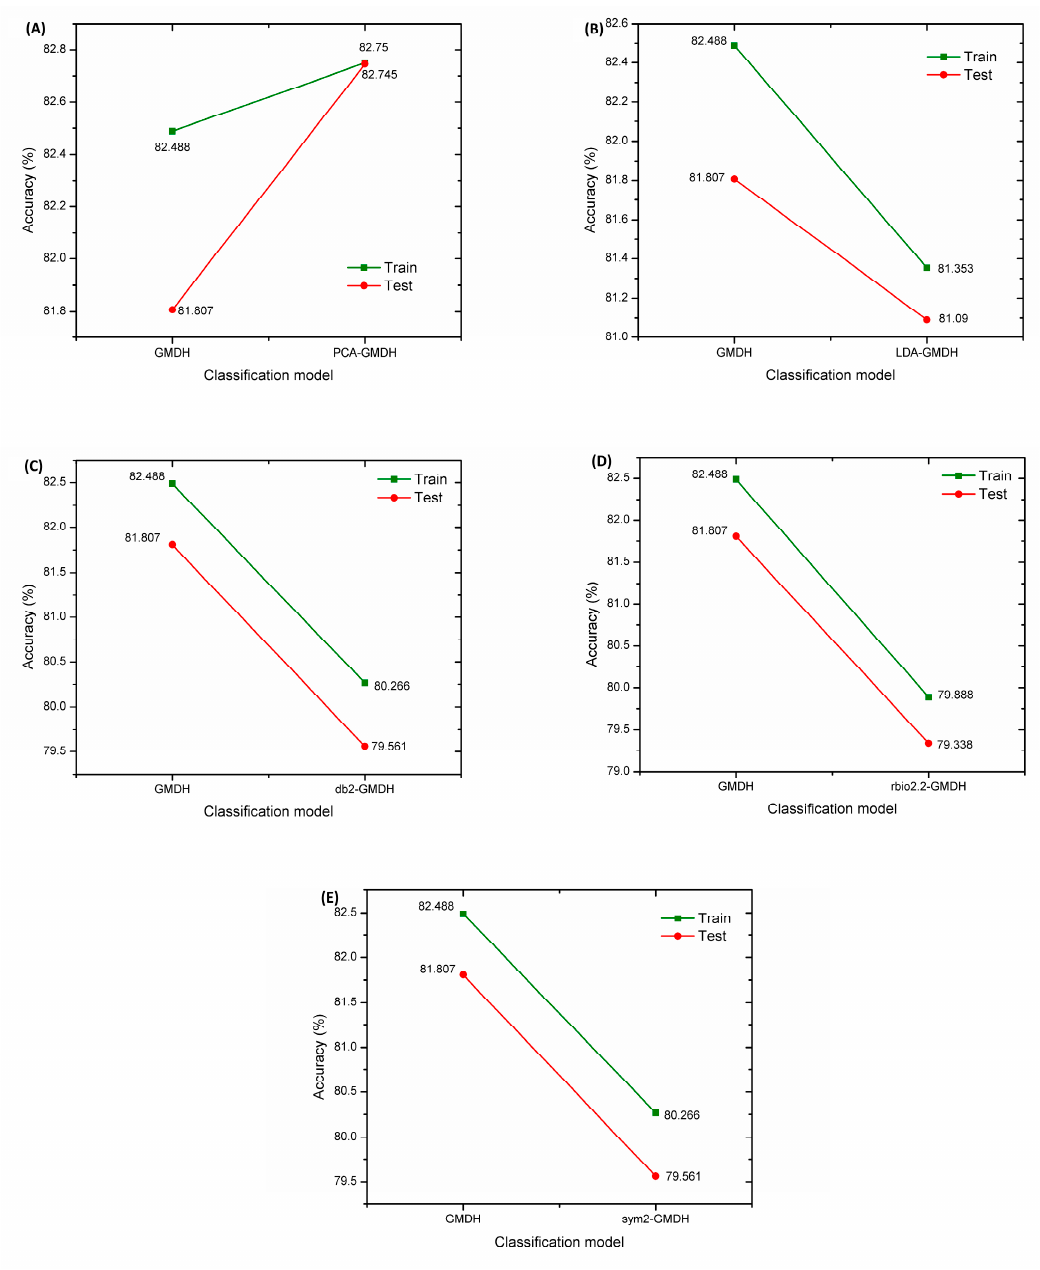
Figure 8. Comparing the classification accuracy of GMDH and ( A ) PCA-GMDH; ( B ) LDA-GMDH; ( C ) db2-GMDH; ( D ) rbio2.2-GMDH; and ( E ) sym2-GMDH.